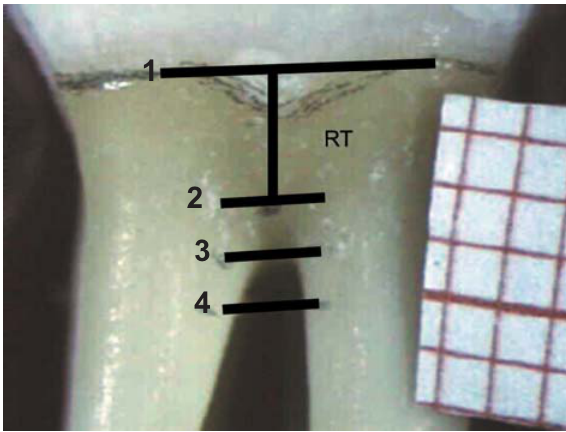
Figure 2- Reference lines 1, 2, 3 and 4 for